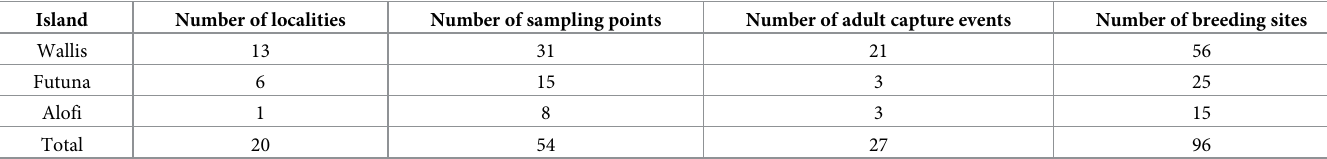
Table 1. Number of localities prospected, sampling points, adult capture events and breeding sites identified for each of the three islands of the Wallis and Futuna territory. Island